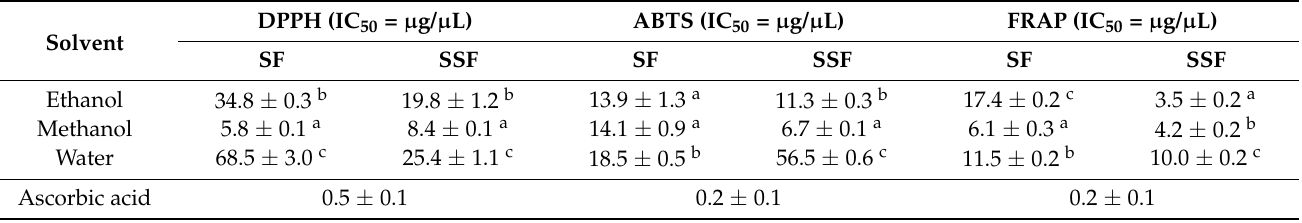
Table 2. The DPPH, ABTS, and FRAP IC 50 values of fresh and steamed Sargassum fusiforme